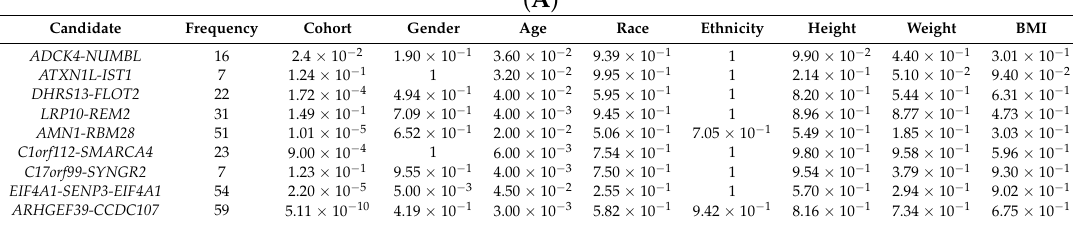
Figure 1. The flow of the study. A list of candidate fusion RNAs that have correlations with aging was generated through bioinformatic analyses on Genotype-Tissue Expression (GTEx) RNA-Seq data. They were then validated using Reverse Transcription Polymerase Chain Reaction (RT-PCR) and Sanger sequencing. Five fusions passed this step and were then evaluated in 20 samples, then extended to 101 samples. Their expression levels were then correlated with donors’ age. Table 1. ( A ) Table of a subset of fusion candidates, their frequencies in GTEx, and their p -values for gender, age, race, ethnicity, height, weight, and Body Mass Index (BMI). ( B ) Primer sequences designed with Primer3 (Whitehead Institute for Biomedical Research, Cambridge, MA, USA) for all confirmed fusions. * Second forward primer designed to amplify the e7e2 form of LRP10-REM2. ( A )